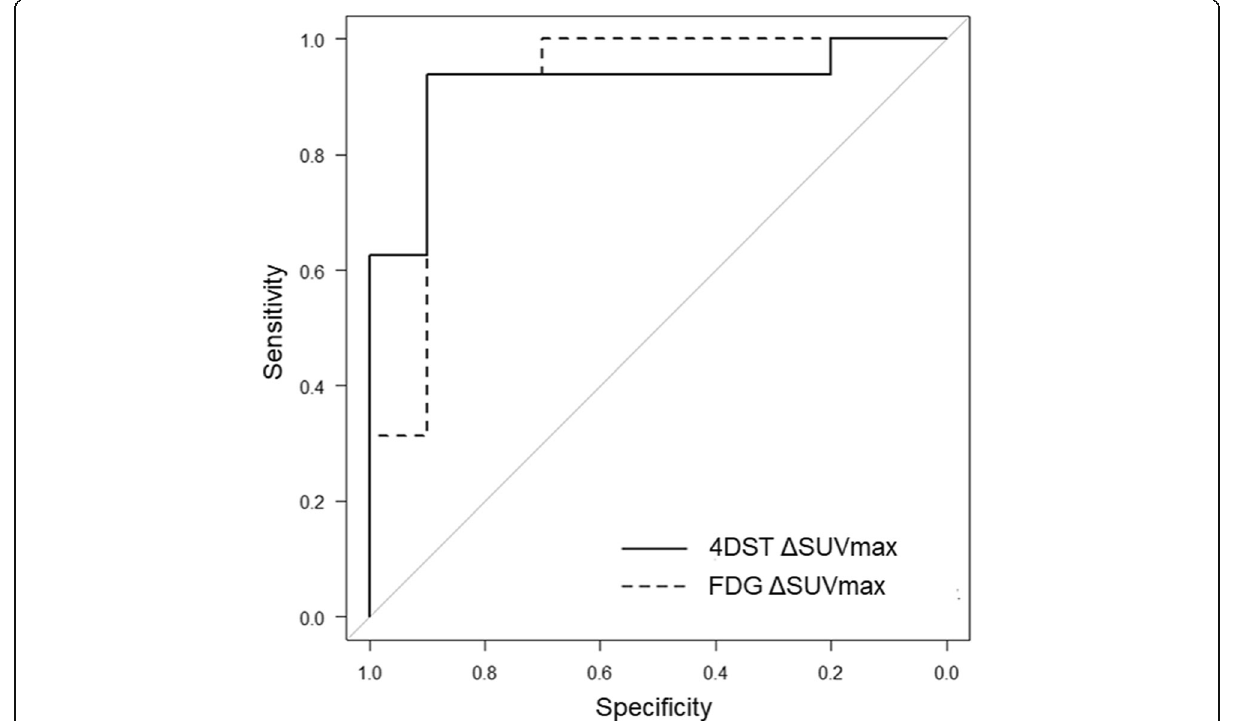
Fig. 2 Receiver operating characteristic curve comparing between 4DST Δ SUVmax and FDG Δ